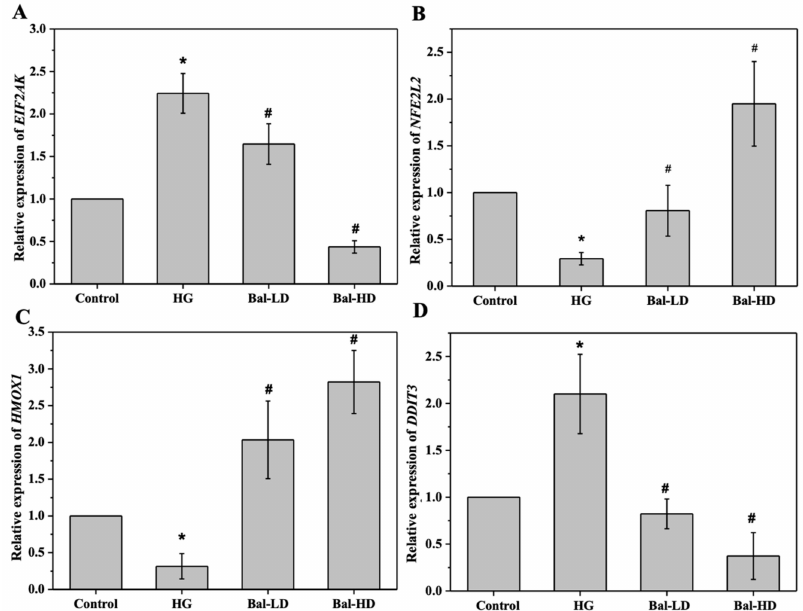
Figure 10. The e ff ect of baicalein on the mRNA levels of EIF2AK3 , NFE2L2 , HMOX1 , and DDIT3 . HL-7702 cells were stimulated with 60.5 mM of glucose and treated with 5 µ M and 20 µ M of baicalein for 24 h. The mRNA levels of EIF2AK (encoding PERK) ( A ), NFE2L2 (encoding Nrf2) ( B ), HMOX1 (encoding HO-1) ( C ), and DDIT3 (encoding CHOP) ( D ) in each group relative to the control was determined by qRT-PCR. The data are represented as the mean ± SD ( n = 3). * p < 0.05 vs. control group; # p < 0.05 vs. HG